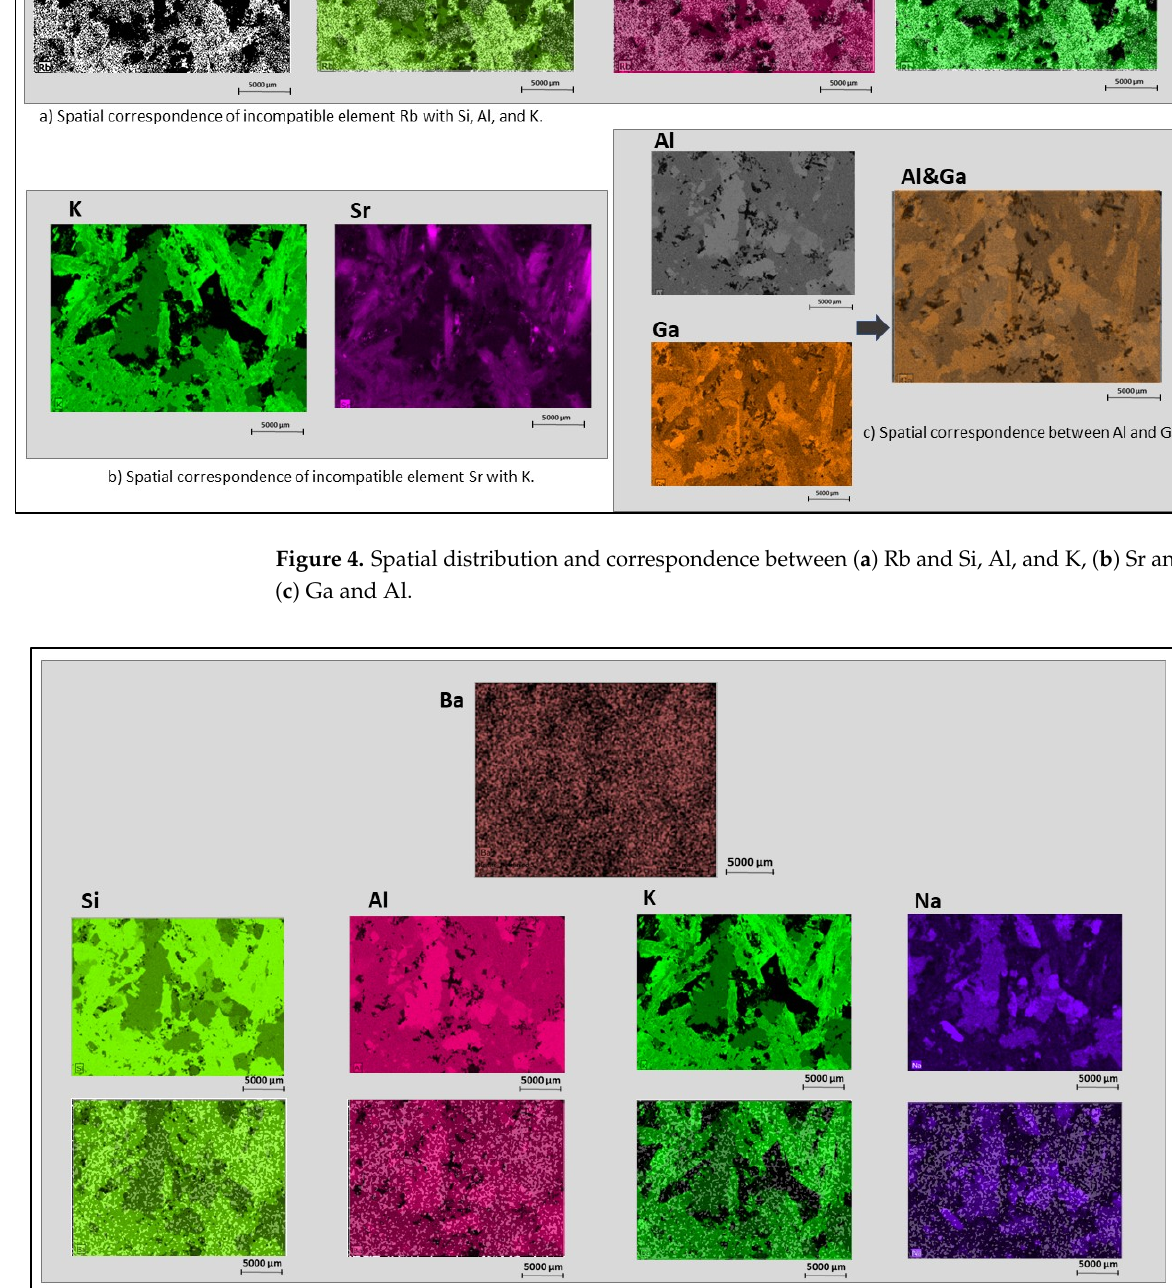
Figure 5. Spatial distribution and correspondence between Ba and Si, Al, K, and Na.